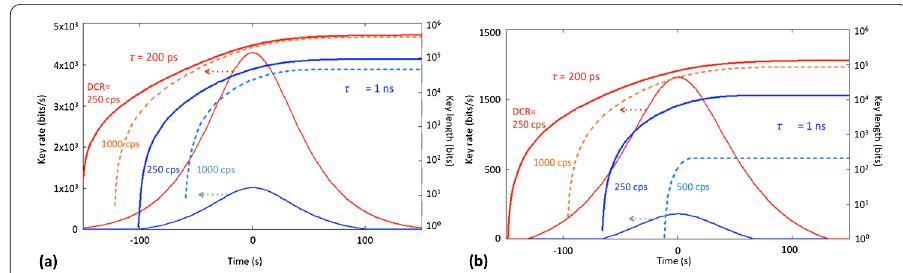
Figure 11 Secure key production during one overpass for two orbital scenarios: ( a ) for a direct overpass, and ( b ) for an overpass at a horizontal distance of 500 km. The origin of the time axes corresponds to the distance of closest approach (550 km, respectively 743 km). In both figures, the bell curves show the secure key rate on the left y -axis. For reasons of clarity, they are shown for only one DCR = 250 cps. The secure key length is given on the right y -axis for two different values of the dark count rate: 250 cps (solid curves) and 1000 cps (dashed curves). The lower (blue) curves are for the case of a source that generates 10 8 pairs/s and τ = 1 ns ( μ = 0.1), while the uppoer (red) curves are for a pair production of 3 · 10 8 s –1 and τ = 200 ps ( μ = 0.06). All other parameters are as in Table 3 and the link attenuations are calculated for atmospheric conditions characterized by r 0 = 20 cm. In the conservative case of τ = 1 ns and R pair = 10 8 s –1 the key length would equal zero bit